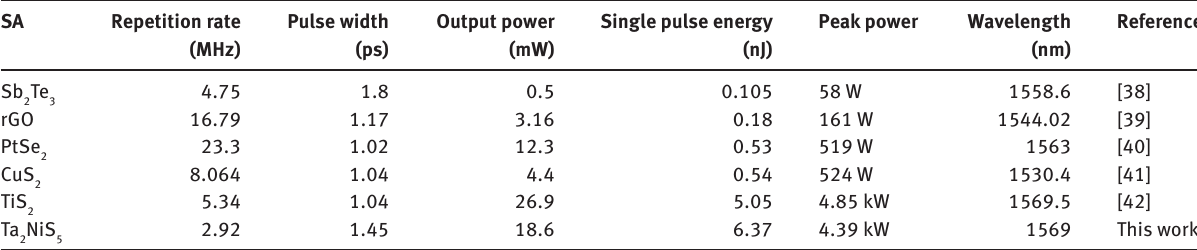
Table 1: Comparison of the output performance of 1.5- μ m mode-locked fiber laser based on various 2D materials. SA Repetition rate